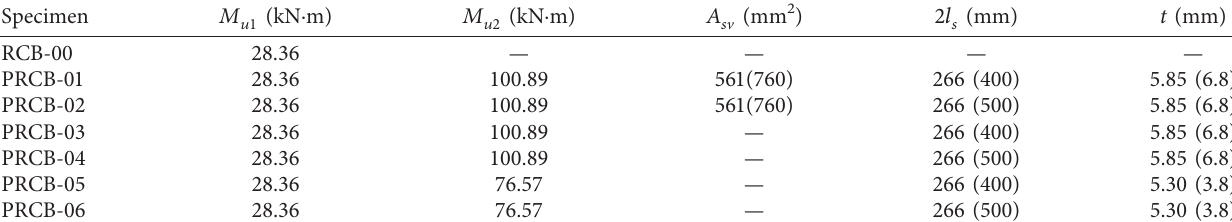
Table 3: Theoretical calculation